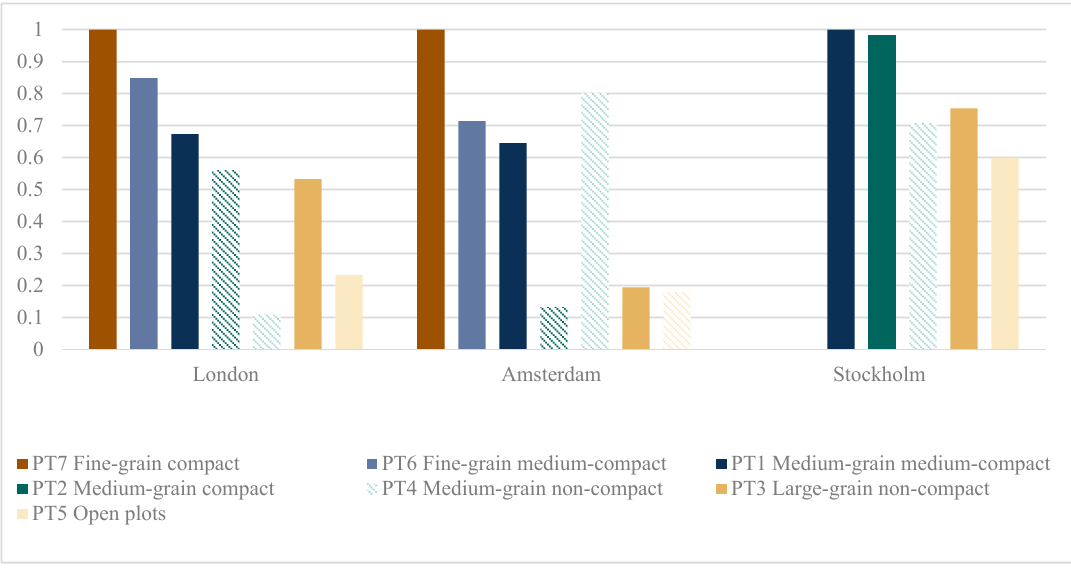
Figure 5. Summary of statistical analysis of differences between the plot types, in terms of dependent variable distribution. The bar charts show mean rank values for each sub-model. “Mean rank” is a relative value and, in order to compare the results between cities, is rescaled to range from 0 to 1. If a particular plot type covers less than 5% of observations within the sub-model, it is shown as a dashed bar.